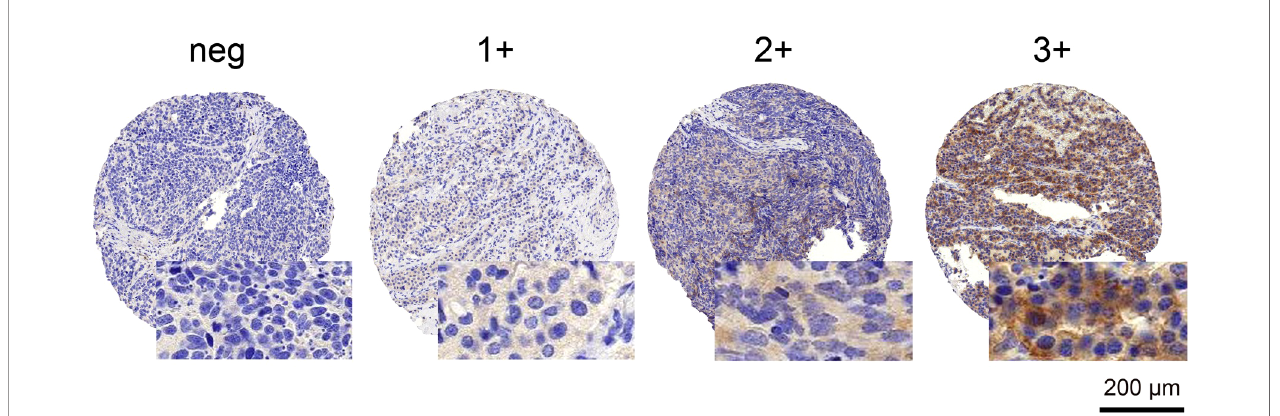
FIGURE 1 | ALK IHC staining patterns. Examples of negative and positive (1+, 2+, and 3+) staining patterns are illustrated. Scale bar 200 µm.